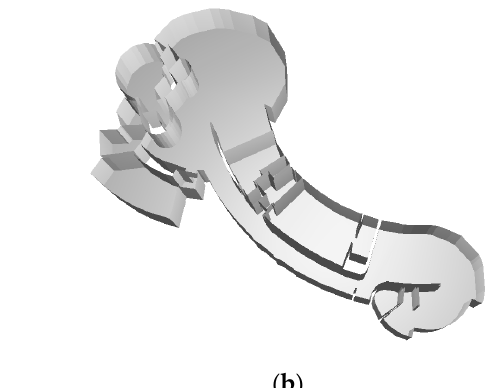
( b ) Figure 15. The comparison between the method using piecewise straight lines to approximate curved line ( a ) and proposed method ( b ).This study proposed a point-based method for curve detection of slice point cloud. The problem can also be solved in 2D domain by projecting the slice point cloud in XOY plane and using image-based method [36]. The image-based method often contains two steps, thinning [37,38] and tracing. It is useful and can detect curved lines quit well. However, the method still has two problems when compared with proposed method. (1) The image-based method can’t distinct the straight parts and curved parts well (Figure 16a). (2) The detected curves are not as smooth as proposed method (Figure 16b). The pixel size has big influence on curved line feature detection. For a larger cell size close to the thickness of the wall, the parallel wall lines won’t be detected. A smaller cell size will cause the thinning step to fail. In the proposed method, vertical walls are assumed to exist in the multi-room indoor environment. However, some structural components, such as oblique walls, may oppose this assumption. Another difficulty arises from transparent glass walls and windows; dataset-2 contains many glass windows that influenced curved wall line detection, as shown in the red box of Figure 12b. While geometric elements are represented as volumetric solids in the IFC standard, the proposed method only models geometric elements as surfaces. Finally, only XYZ coordinates are used to detect wall opening elements in this study; therefore, more cues (e.g., color and intensity) can be used to detect wall opening elements and obtain more precise results.